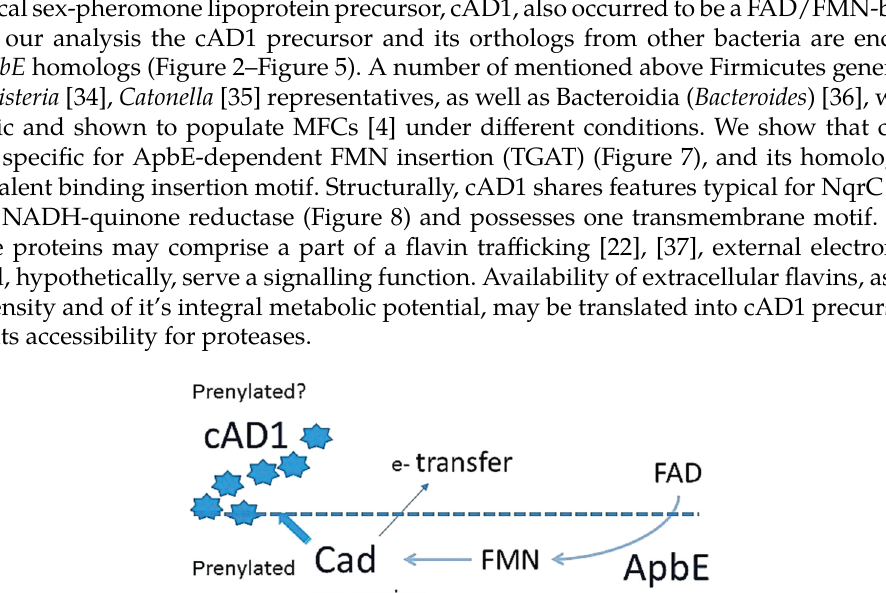
Figure 8: Results of comparison of the reconstructed tertiary structure of cAD1 to the library of known 3D protein struc- tures via Phyre2 (Protein Homology/analogY Recognition Engine V 2.0 analysis).